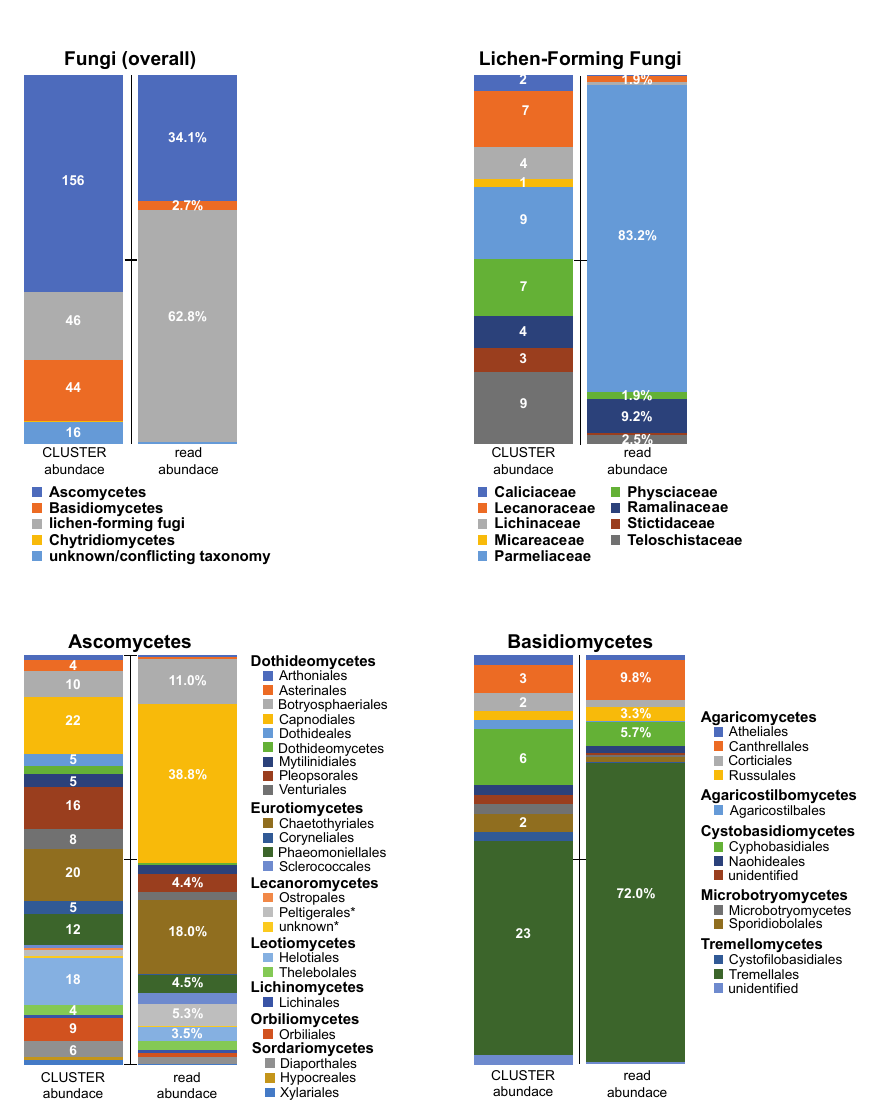
Figure 4. Fungal diversity inferred from DNA metabarcoding at “Geyser Pass 2” sites using the ITS2 barcoding marker. Panels compare taxonomic identity of genetic clusters ( left ) and proportion of short read data assigned to each taxonomic group ( right ). Top left panel represents an overview of taxonomic assignments from short read data; top right panel represents lichen ‐ forming fungi; bot ‐ tom panels represent other lichen ‐ associated ascomycetes ( bottom left ) and basidiomycetes ( bot ‐ tom right ) represent in bulk samples. From the short read data, we inferred eight haplotypes in Evernia divaricata , 13 in Ramalina sinensis , and 104 representing Usnea species, the vast majority represented U. cavernosa (Table 3; Supplementary File S8).